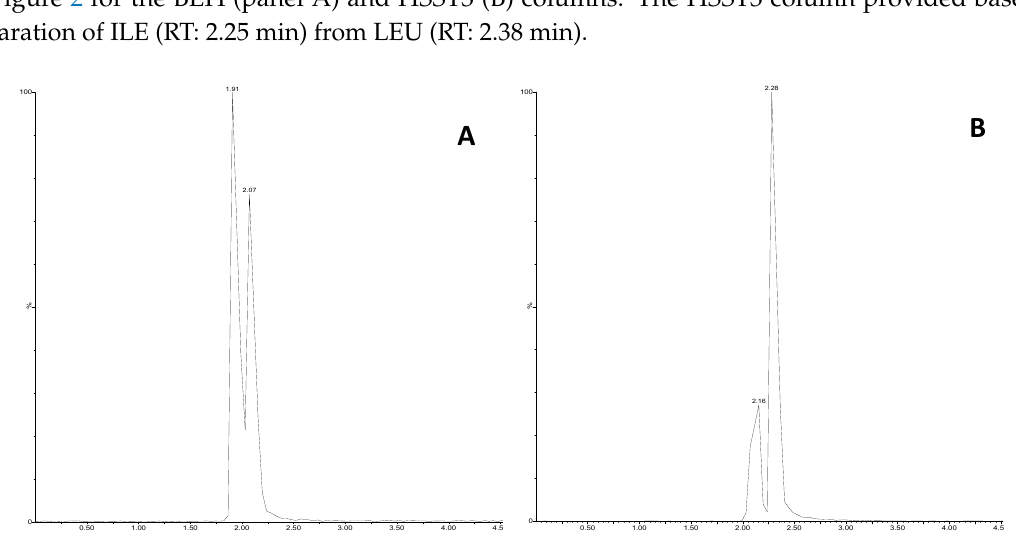
Figure 2. MRM (132.096 > 86.0) for ILE (left peak) and LEU (right peak) in plasma samples. ( A ): Waters ACQUITY BEH C 18 1.7 μ m, 2.1 × 150 mm; ( B ): Waters ACQUITY HSST3 1.8 μ m, 2.1 × 150 mm .